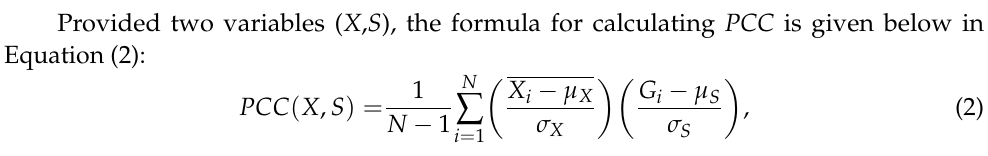
Figure 5. The PCC of each variable with the SI for all the dataset locations.